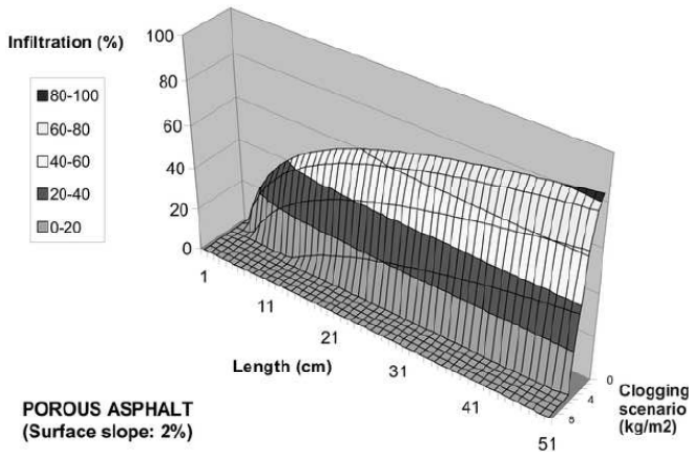
Figure 4. Permeability results of PA surface obtained with CFI